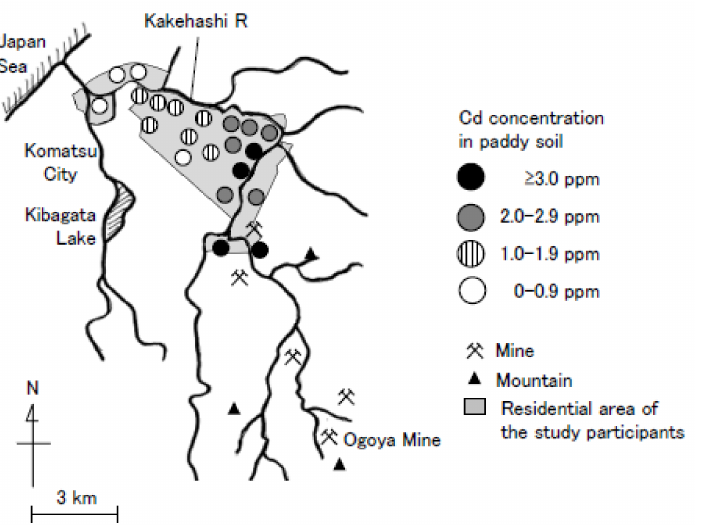
Figure 1. Location of copper mines and the cadmium (Cd)-polluted area of the Kakehashi River basin. (Source. Ishikawa Prefecture,